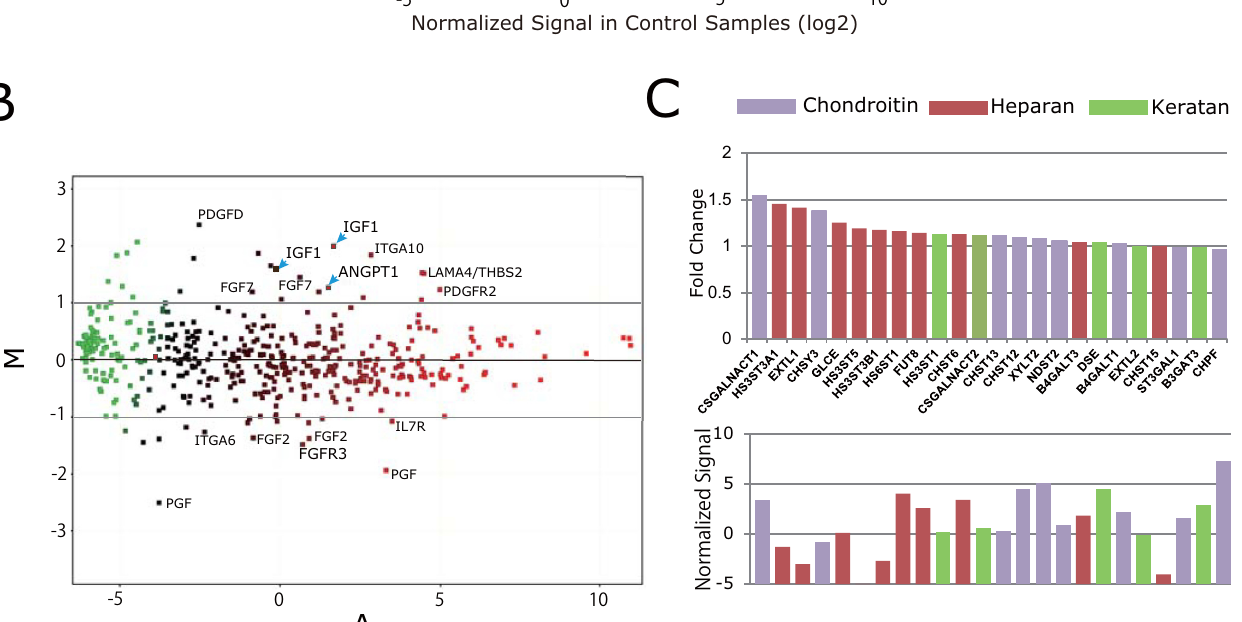
Fig 3. Gene expression profiling. A) Genes upregulated more than two-fold compared with control (above the upper green line), downregulated more than two-fold below control (below the lower green line), and genes that changed less than two-fold (between the green lines) are plotted logarithmically for 1.0 mNU/ml NTP with AsAP (1.0NTP+AsAp) treated samples versus control. Data were normalized for 75-percentile. B) MA plot for genes belonging to the phosphatidylinositol 3-kinase (PI3K) signaling pathway selected by KEGG PATHWAY Database. Genes upregulated or downregulated two-fold or more compared with control (above/below the green line), and genes with less than two-fold changes (between the green lines) are plotted. M = log 2 (1.0NTP+AsAP) -log 2 Control, A = [log 2 (1.0NTP+AsAP) -log 2 Control] / 2. C) Genes related to the sulfated glycosaminoglycan synthesis were analyzed and the top 24 genes by the magnitude of change resulting from 1.0NTP +AsAP treatment are shown (upper panel) with the differences in signal levels (lower panel). Chondroitin sulfate N-acetylgalactosaminyltransferase 1 (CS GALNACT1 ) was found to be upregulated 1.54 times compared with control. Data are presented as the average of N =